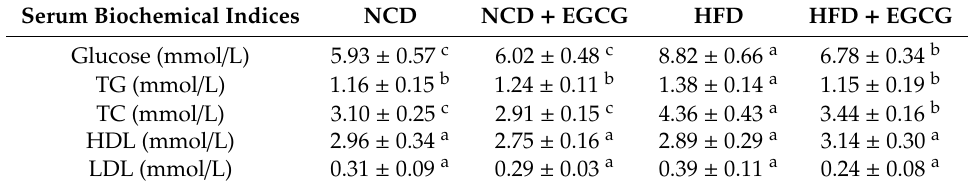
Table 1. E ff ects of ( − )-epigallocatechin gallate (EGCG) on serum biochemical parameters. Table 1. Effects of (−)-epigallocatechin gallate (EGCG) on serum biochemical parameters. Serum Biochemical Serum Biochemical Indices